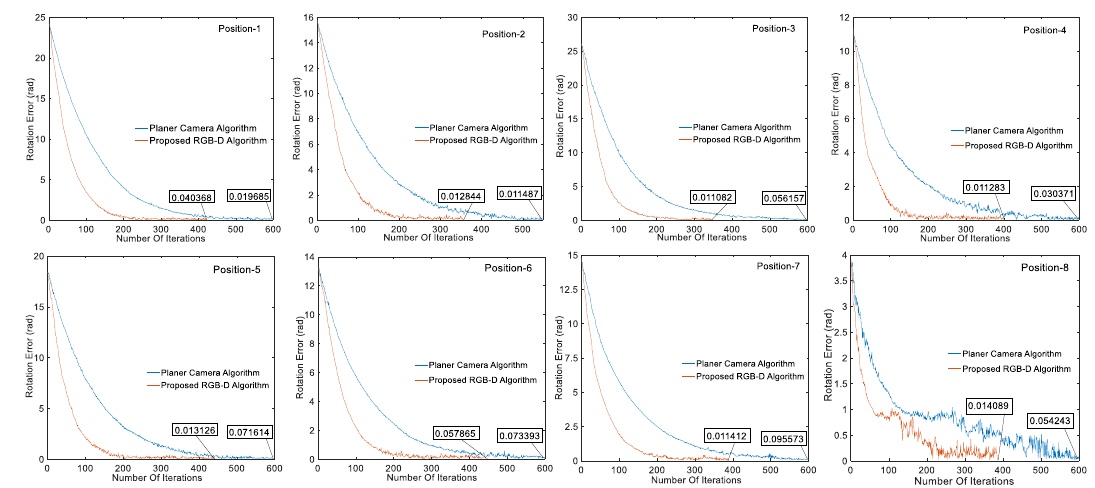
Figure 11. Change of manipulator rotation error in di ff erent positions.